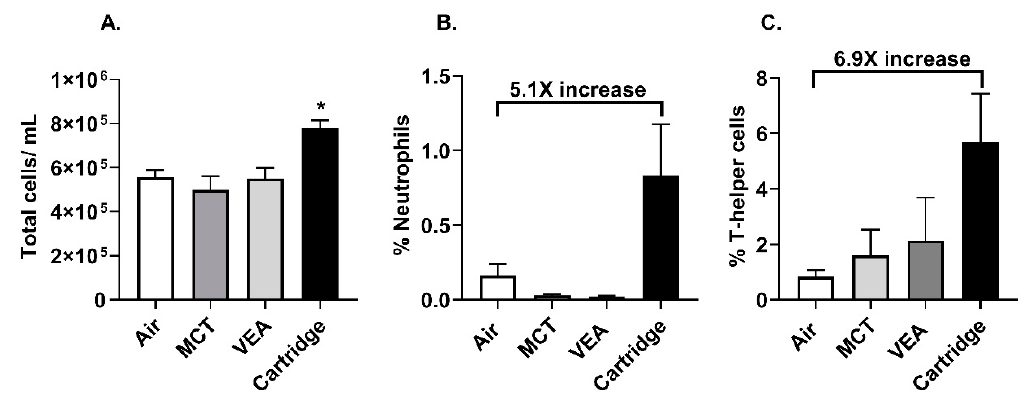
Figure 5. Exposure to aerosols from e-cig vape cartridges induced a differential immune cell influx. C57BL/6 background wild type mice were exposed to MCT, vitamin E acetate 50% w/v , and six unknown cartridges with one puff a minute, 1 h/d for three consecutive days. Mice were sacrificed immediately after the last exposure and the immune cells in the bronchoalveolar lavage fluid (BALF) were assessed. ( A ) Total cells in air, MCT, VEA, and e-cig cartridge exposed BALF. One-way ANOVA * p < 0.05 vs. air ( n = 5). ( B ) Neutrophil count in BALF ( n = 5). ( C ) CD4+ cell count in BALF ( n = 5). p > 0.05 vs. air were considered nonsignificant and were not denoted with asterisks.